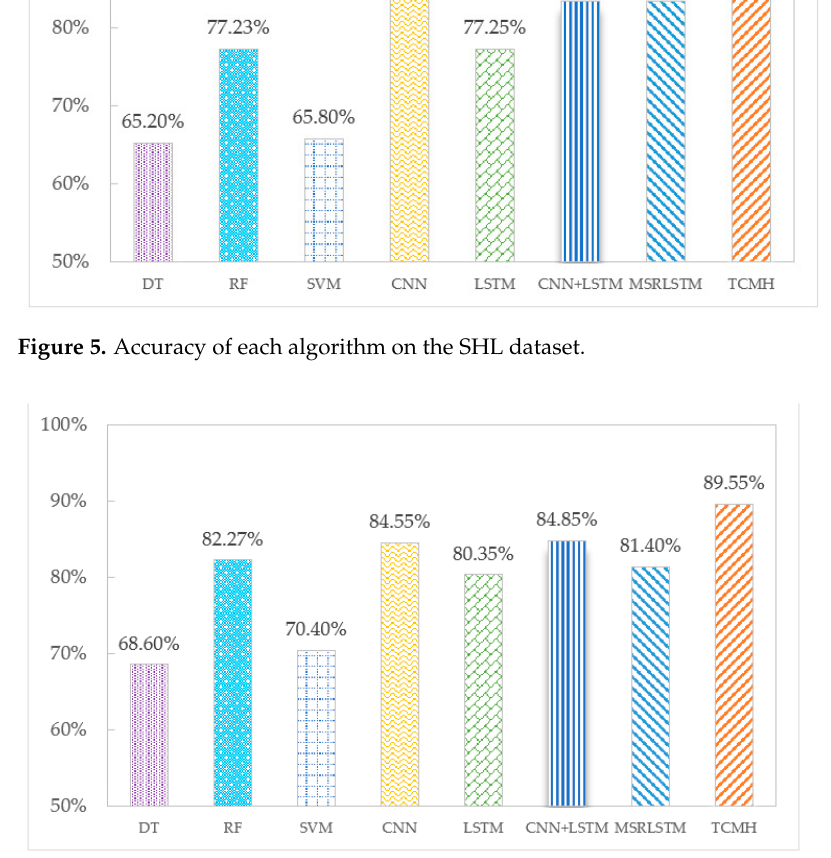
Figure 6. Accuracy of each algorithm on the HTC dataset .